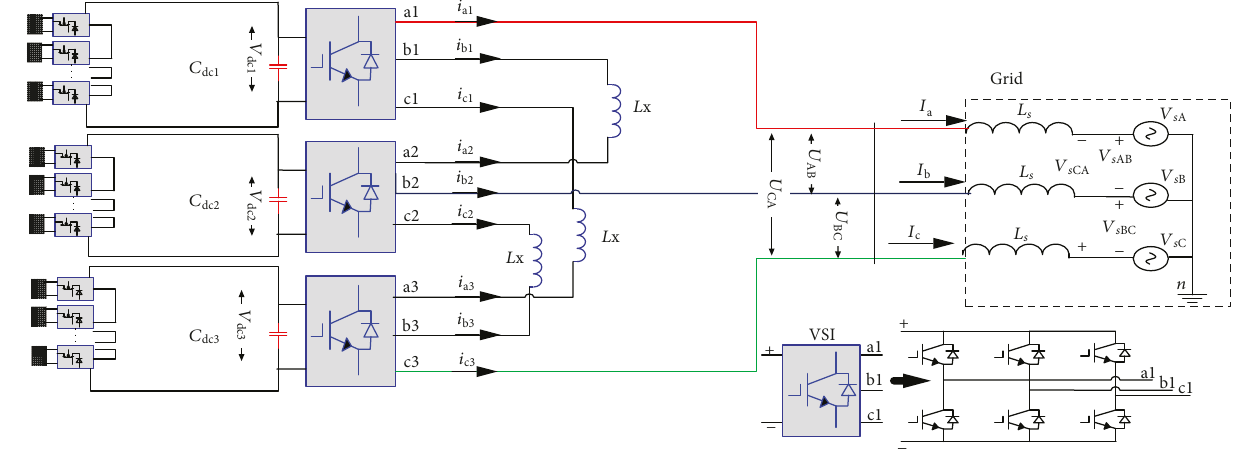
Figure 2: Three-phase cascaded H-bridge